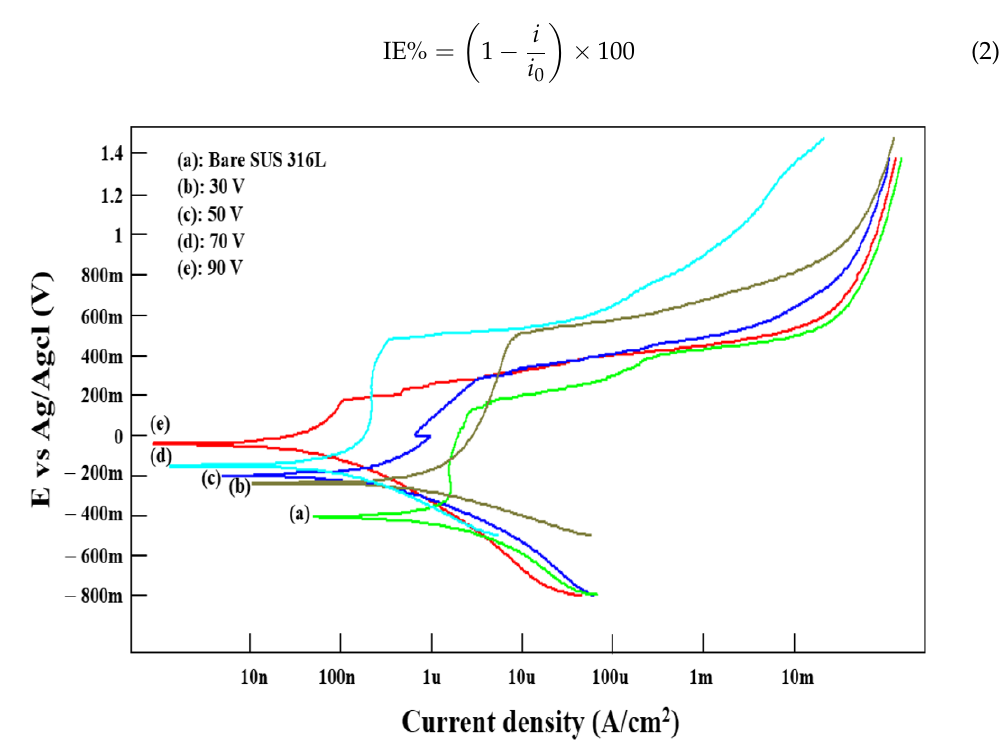
Figure 6. PDP test result of bare SUS 316L and 316L of FDTS-coated stainless steel anodized according to each applied voltage. Table 5. PDP test values of bare SUS 316L and anodized stainless steel 316L with FDTS coating according to the applied voltage.